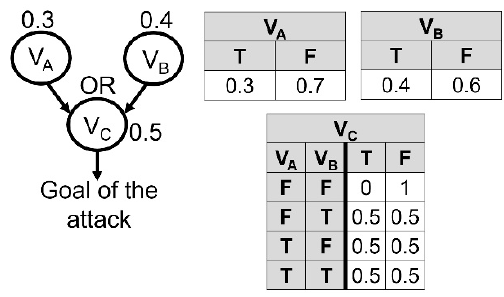
Figure 3. A Bayesian network attack graph example .